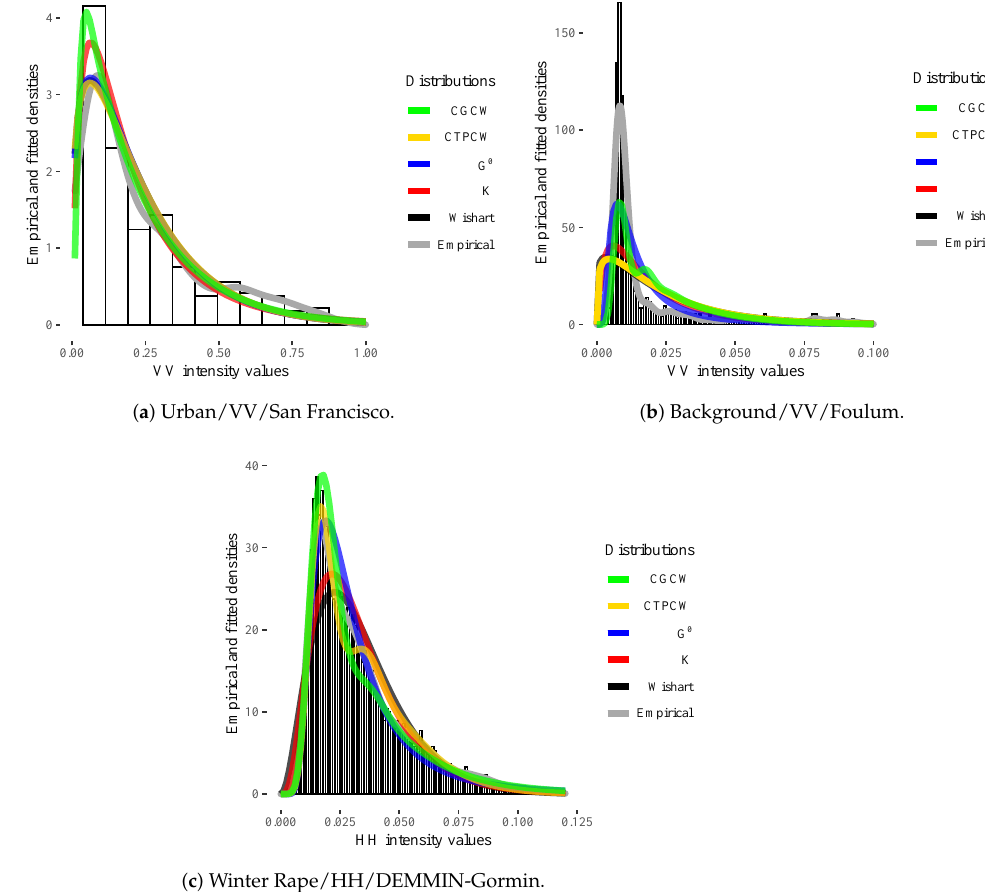
Figure 11. Empirical and fitted densities for San Francisco, Foulum and DEMMIN-Gormin